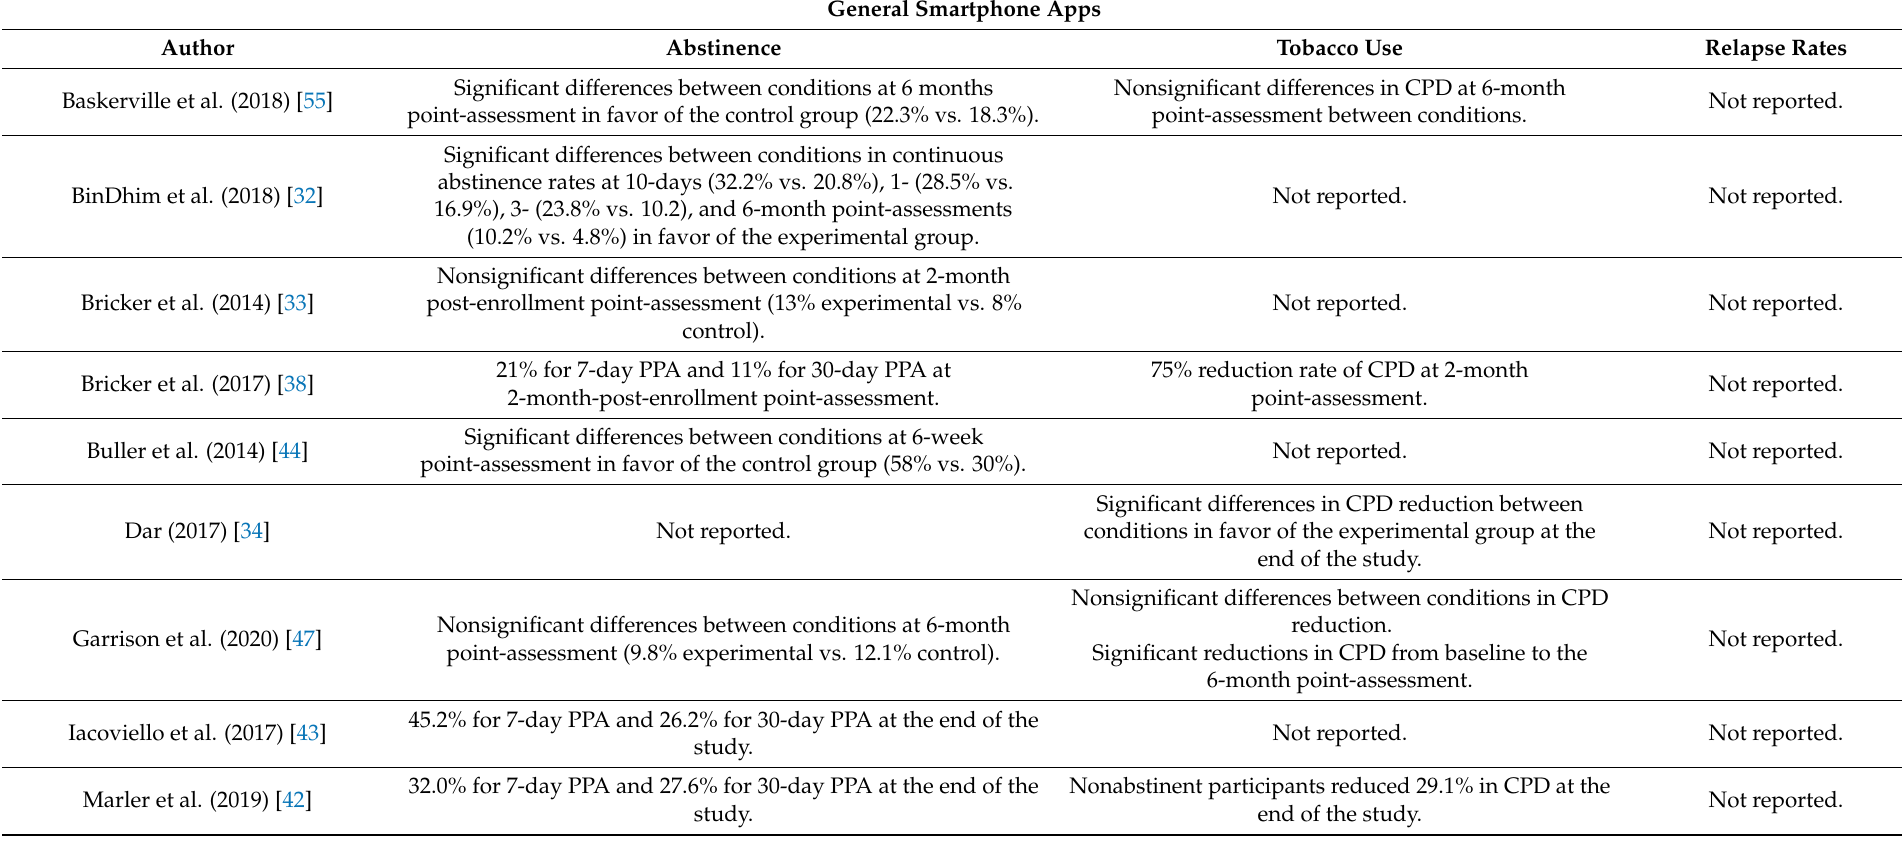
Table 2. Main smoking cessation outcomes according to apps